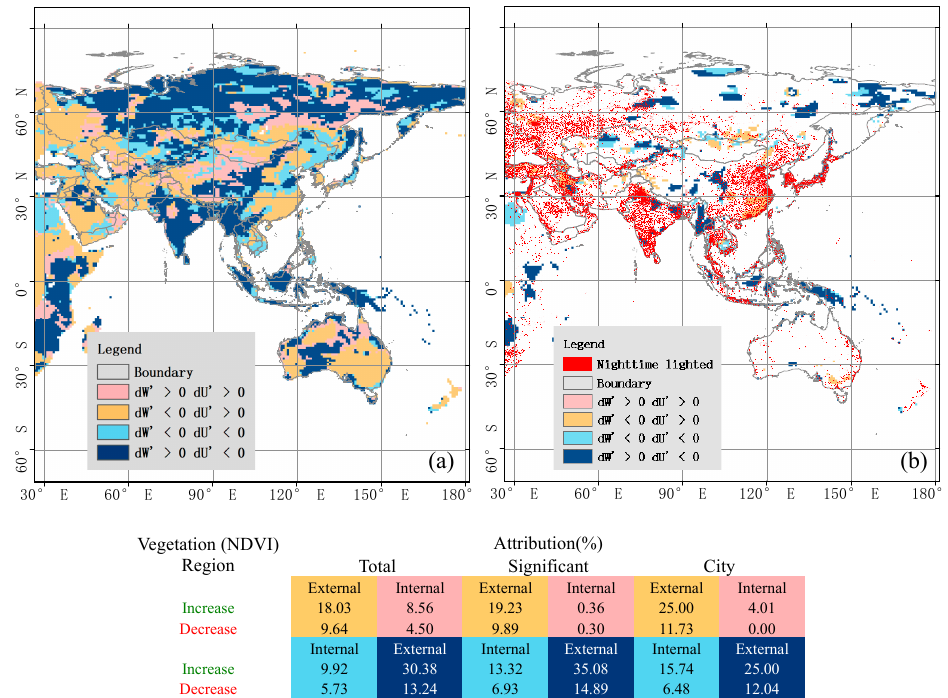
Figure 3. Distributions and statistics of attribution classes of ( a ) ecohydrological and ( b ) significant ecohydrological change in Asia and Australasia separating internal from external causes in three land surface states, characterizing the mean and its change and the mean of urbanization of the land